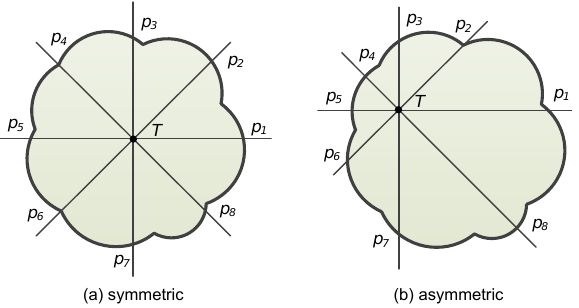
Figure 2: Asymmetric ratio calculation of (a) symmetric and (b) asymmetric tree crowns. ( ̅̅̅̅ are the radii in different directions) (ii) Area Ratio Function ( ) Another area ratio term ( ) is also included to reinforce the assessment of the geometric features of objects in the